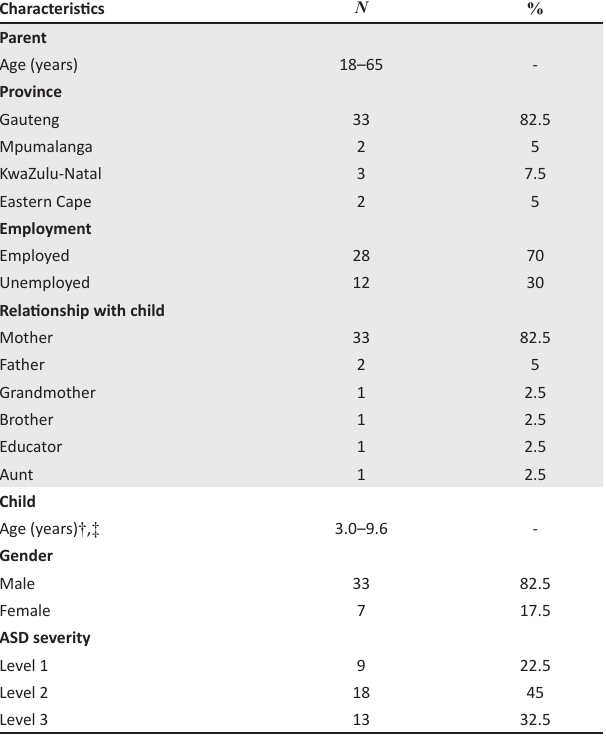
TABLE 1: Participant description and characteristics. Characteristics